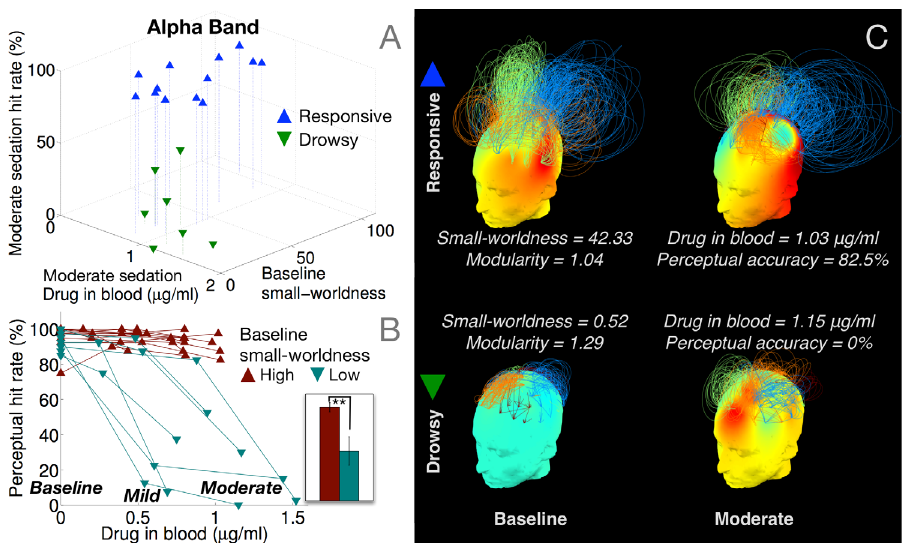
Fig 6. Baseline alpha band networks predict loss of responsiveness during moderate sedation. Participants in the drowsy group had relatively lower small-worldness (A) already at baseline. Median split of participants based on baseline small-worldness predicted eventual loss of responsiveness (B) despite similar blood levels of drug concentration during moderate sedation